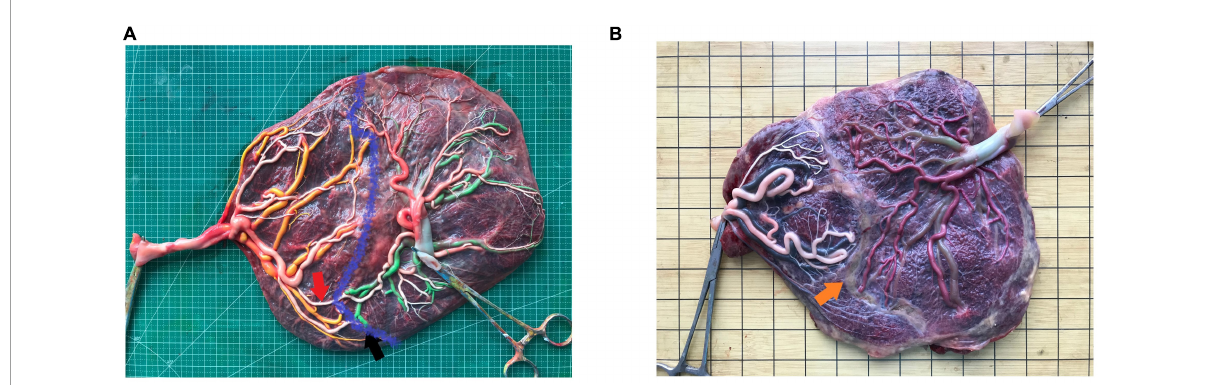
FIGURE1 An image of the placenta after dye injection (A) placenta without laser surgery, red arrow, artery-artery anastomosis, black arrow, artery-vein anastomosis, blue curve, placental separate line; (B) placental with laser surgery, orange arrow, laser coagulation line.